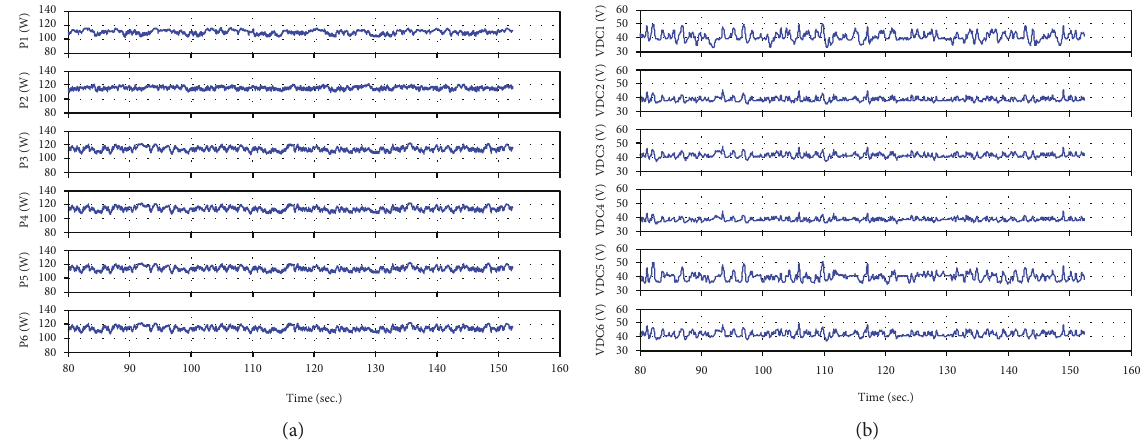
Figure 16: (a) DC-link voltages. (b) Maximum power point tracking of the PV